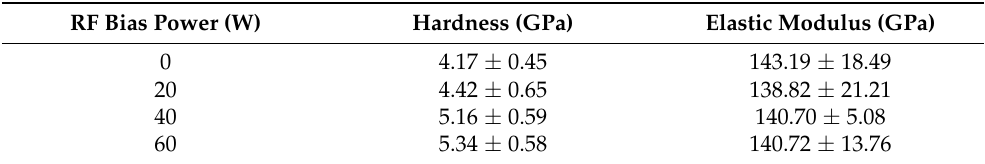
Table 1. Hardness and elastic moduli of the Nb films deposited under different RF bias powers, calculated based on the load-displacement